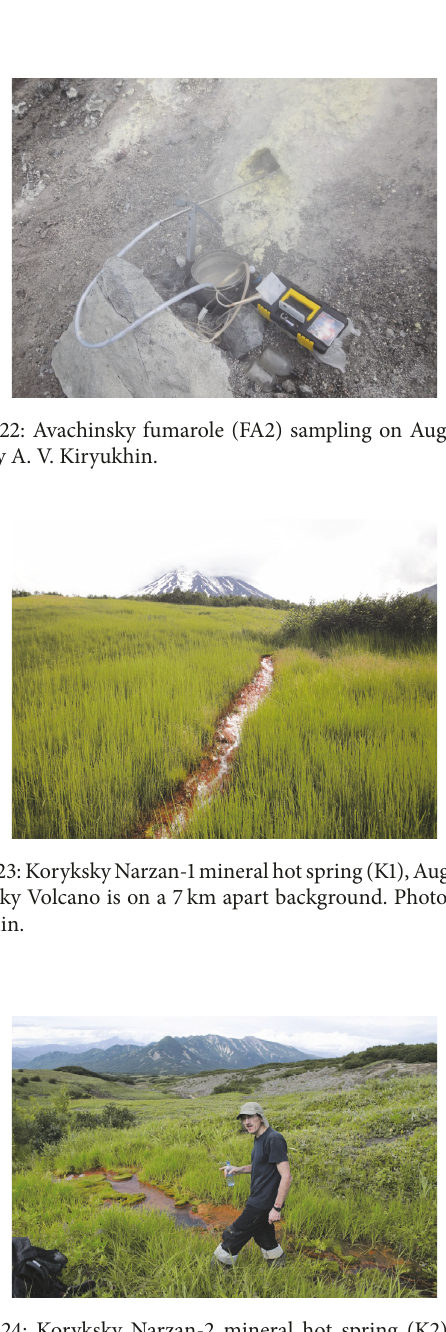
Figure 24: Koryksky Narzan-2 mineral hot spring (K2), August 2014. Photo by A. V.